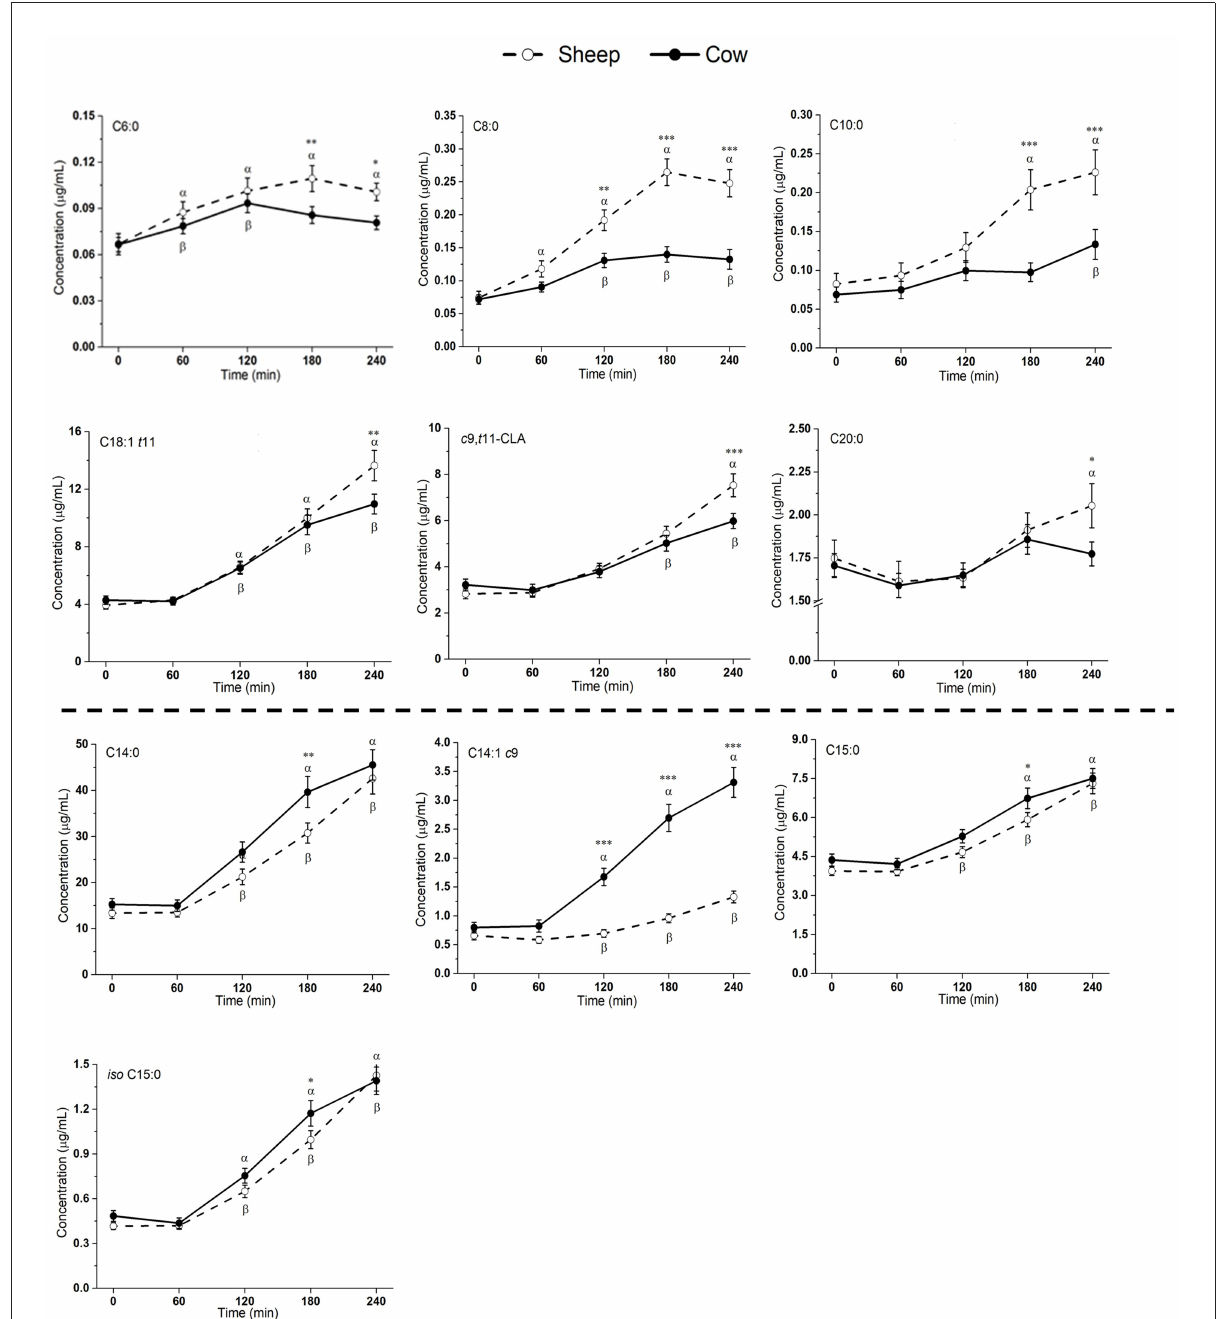
FIGURE3 Postprandial changes in fatty acids that differed significantly in plasma following ingestion of SM and CM. Values presented as means ± SEM; * p < 0.05, ** p < 0.01, *** p < 0.001 denoted statistical significance (interaction time × milk) between sheep () and cow () milk; α and β denote significant changes ( p < 0.05) from baseline after sheep and cow milk ingestion, respectively (Sidak corrected post hocs). SM, sheep milk; CM, cow milk.